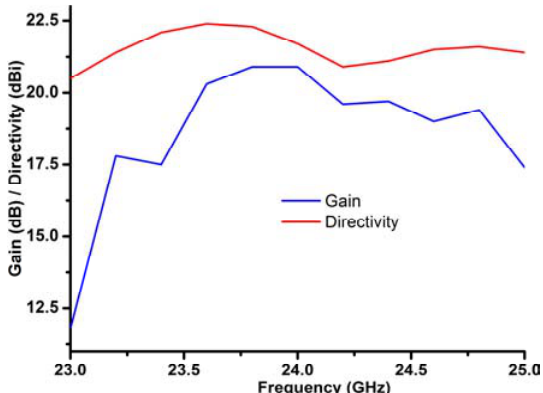
Figure 10: CST simulated gain and directivity of the proposed NDRA array.